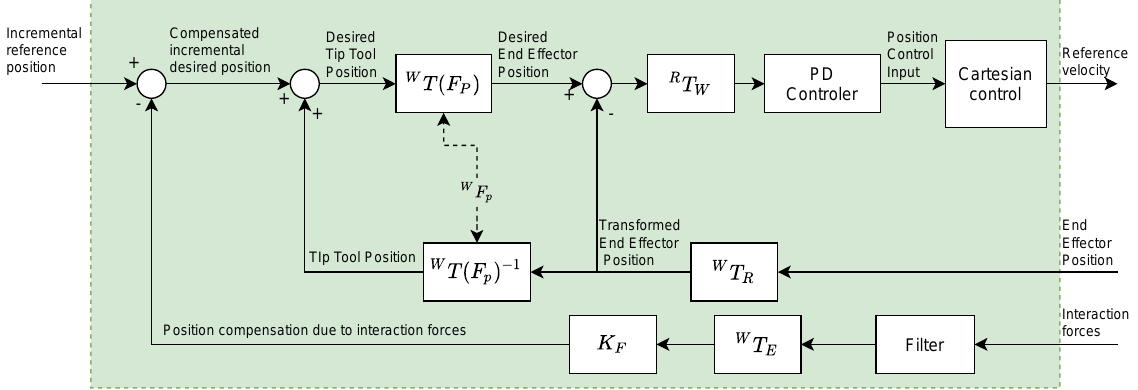
Figure 4. Block diagram of the control system with force feedback. The interaction between the robot and the endonasal cavity generates the Interaction forces that are measured by the force sensor (HEX-1 for teleoperated robot and HEX-2 for autonomous robot). This signal is filtered using a moving average filter (which will be described later). Next, a force-position transformation is performed using the K F constant (mm/N) (whose value will be determined later). Thus, the Position compensation due to interaction forces is obtained, which constitutes the feedback of the system. The position and orientation of the tool center point (TCP) (HOPKINS endoscope), is used to calculate the Tip Tool Position, taking into account the W F P (Fulcrum point). Blocks i T j represent the transformation of positions and forces from the reference frame j to the reference frame i . As the block diagram shows, from Interaction forces and End Effector Position the Desired End Effector Position is calculated, which once transformed ( R F W ) to coordinates of the reference system associated with the base of the autonomous robot, is defined as the input to the Proportional-Derivative (PD) controller. The output signal of this controller is the position control input, which will be transformed into a velocity reference, which constitutes the input to the robot controller, using the SpeedJ and SpeedL commands, previously